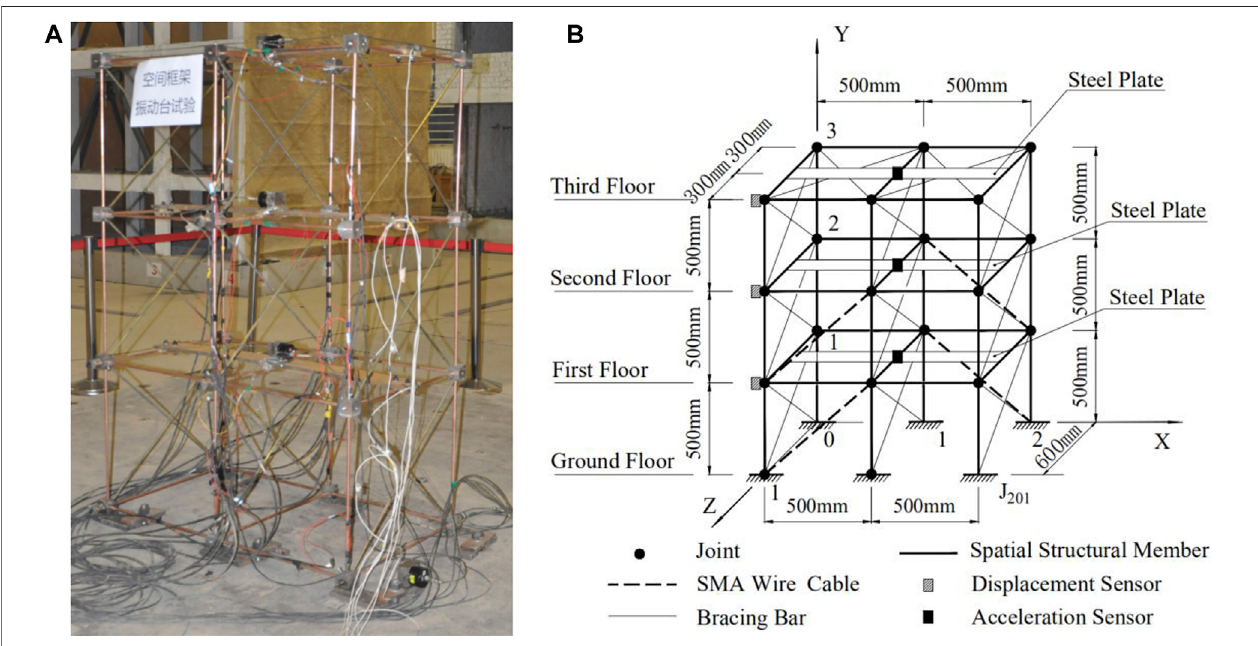
FIGURE 4 | Experimental model of spatial skeletal structure: (A) real model, (B) schematic model and sensors.